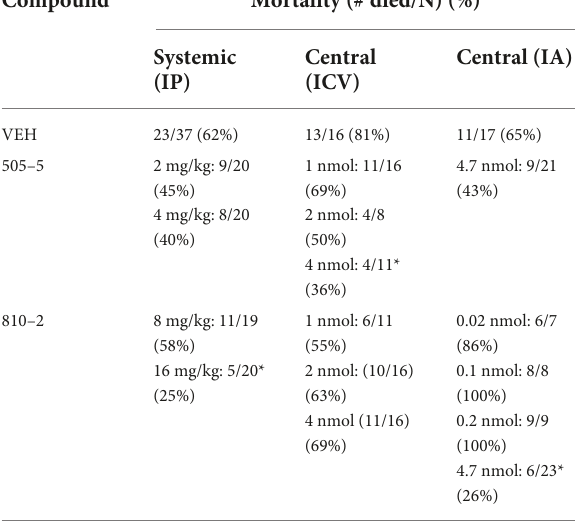
TABLE 1 Systemic and central administration of galanin analogs: effect on (S-IRA) in C57B1/6J